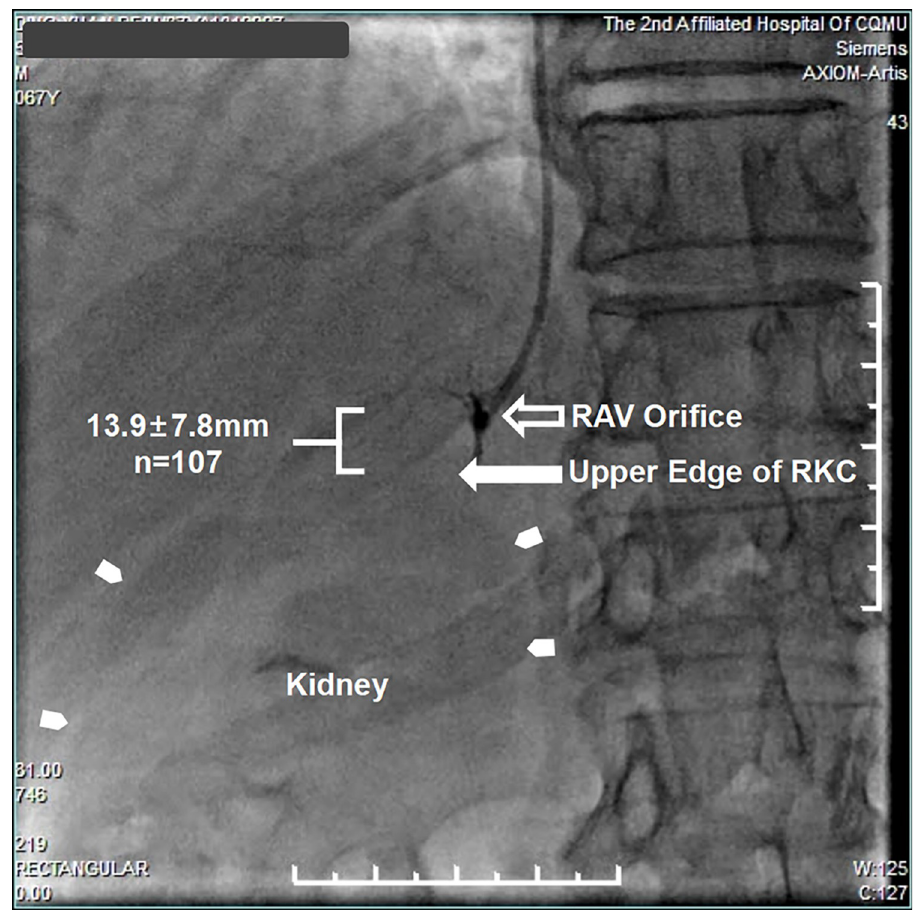
Fig 1. Relationship of the RAV orifice and RKC under fluoroscopy. The mean distance from the RAV orifice ( open arrow ) to the upper edge of RKC ( solid arrow ) was 13.9 ± 7.8mm in 107 PA patients. The tiny arrow head indicated the RKC. RAV: Right Adrenal Vein, RKC: Right Kidney Contour .